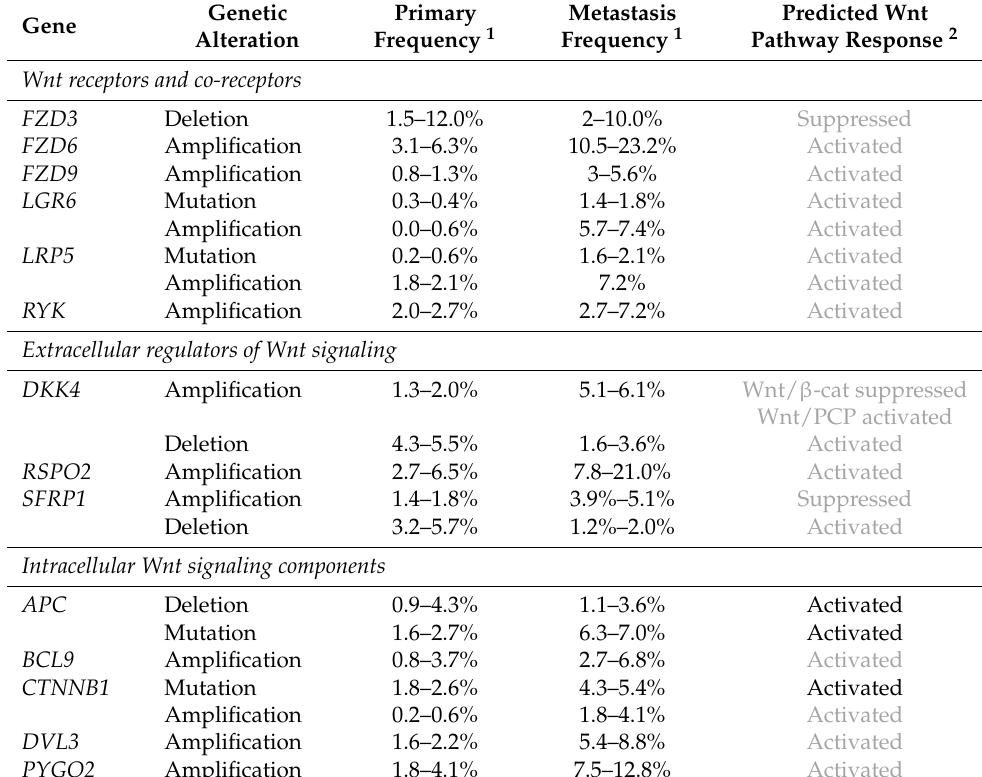
Table 1. Common Wnt pathway genetic variants in prostate